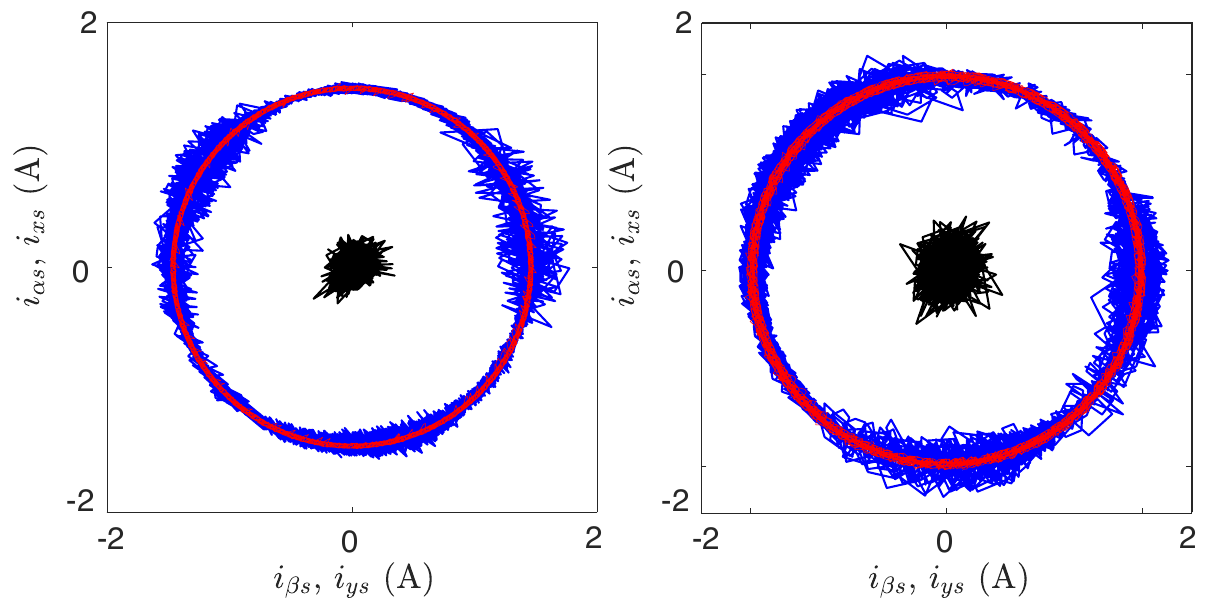
Figure 4. Steady-state response of { α , x , β , y } stator currents for two different desired rotor speed ω d r : results from left to right for 1000 and 1500